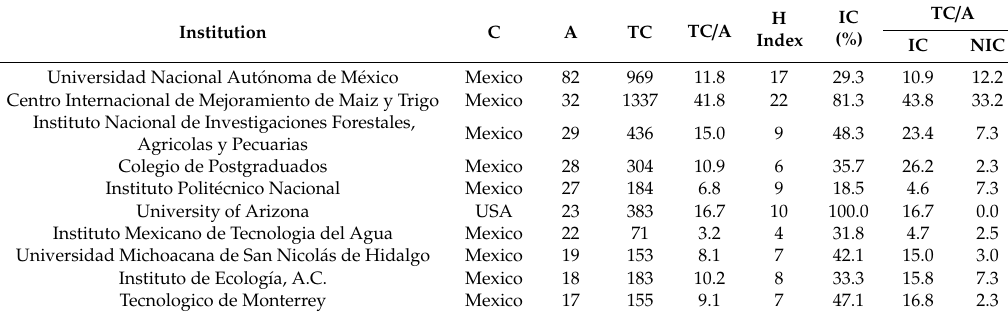
Table 7. Major characteristics of the most active institutions related to SAWMM